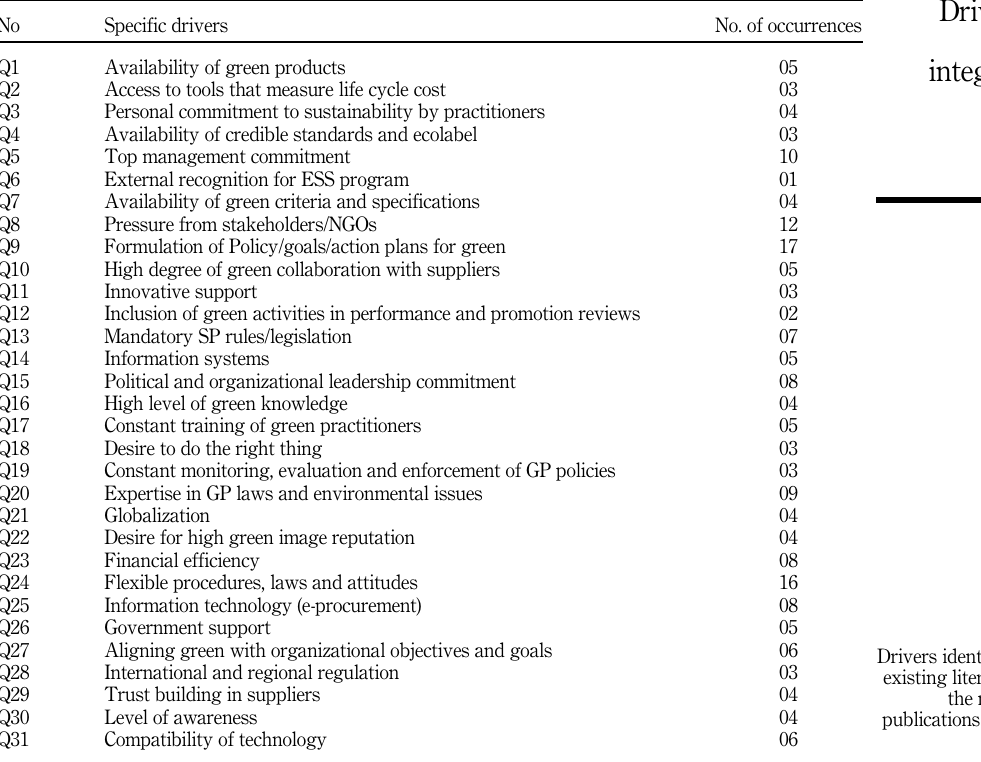
Table 2. Drivers identified